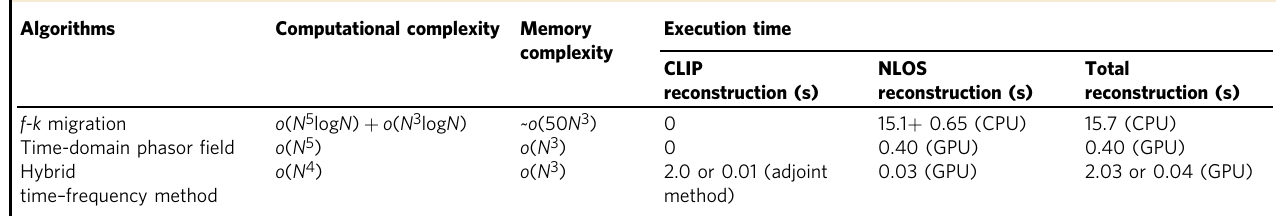
Table 1 Comparison of NLOS imaging computation and memory